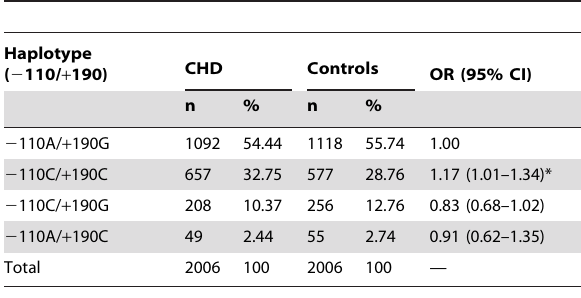
Table 3. Haplotype Distribution of HSPA1A in CHD and Control Group.